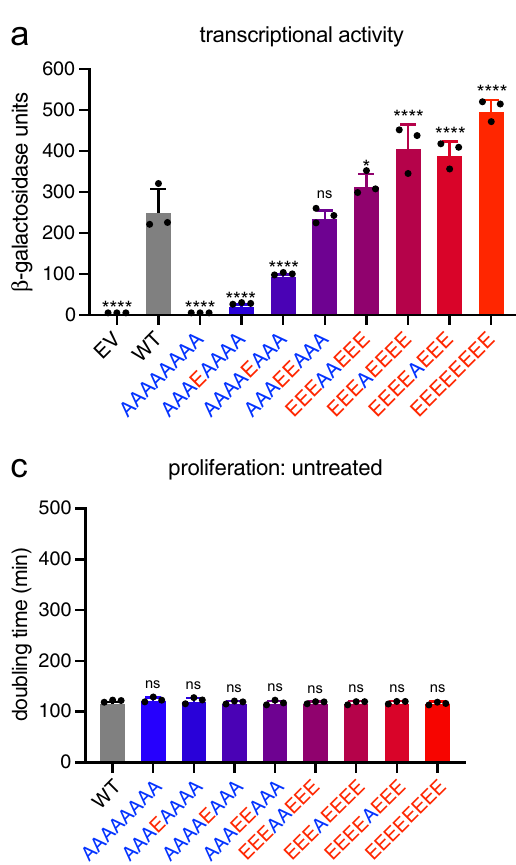
proteinsexpressedfromtheendogenous HCM1 locus.Hcm1wasdetectedusingan antibody against the C-terminal 3V5 tag, PSTAIRE shown as a loading control. Representativeblotsfrom n =3replicatesareshown. c , d Doublingtimesofstrains from ( b ) growing at 30°C in rich medium ( c ) or in rich medium with 5 μ g/mL nocodazole ( d ). Gray represents WT, color gradient from blue ( hcm1-8A ) to red ( hcm1-8E )correspondstoincreasingnumbersofphosphomimeticmutations.Error bars represent standard deviation, shown is an average of n =3 replicates. Sig- ni fi cance was tested using repeated measures one-way ANOVA with Dunnett ’ s multiple comparisons test. Asterisks indicate signi fi cantly different from WT, **** P <0.0001, *** P <0.0005, ns=non-signi fi cant. d AAAAAAAA P